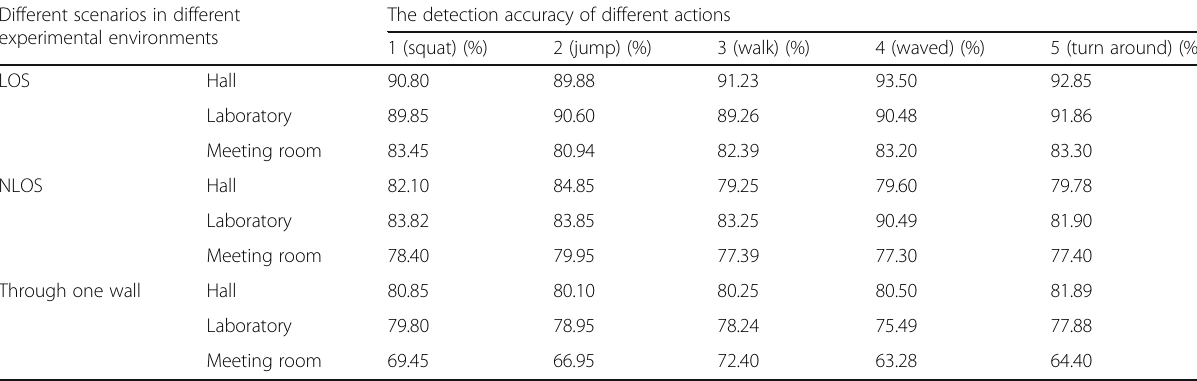
The detection accuracy of different actions